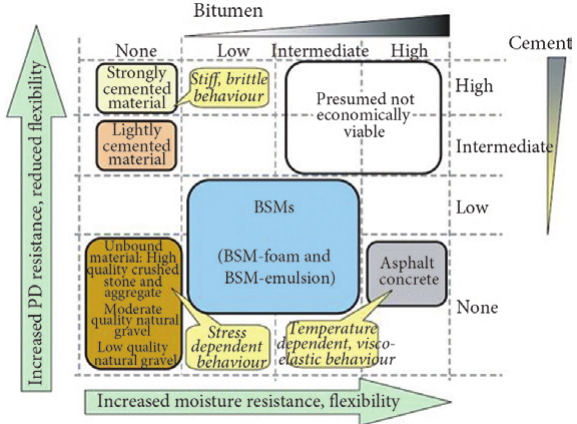
Fig. 1. Effect of bitumen binder and cement content on the behaviour of materials according to Technical Guideline TG2 by Asphalt Academy Table 1. Parameters of foamed bitumen (85N) Parameters